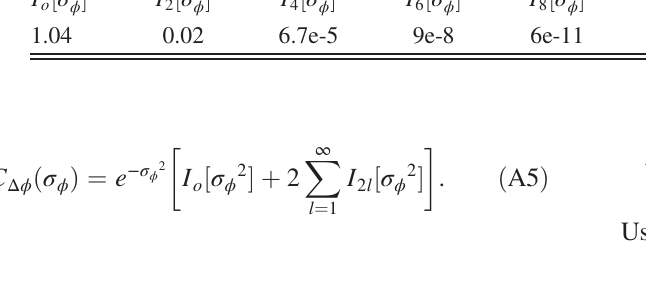
TABLE IV. Contribution of synchrotron sideband harmonics to correction factor for σ ϕ ¼ 0 . 6325 rads.